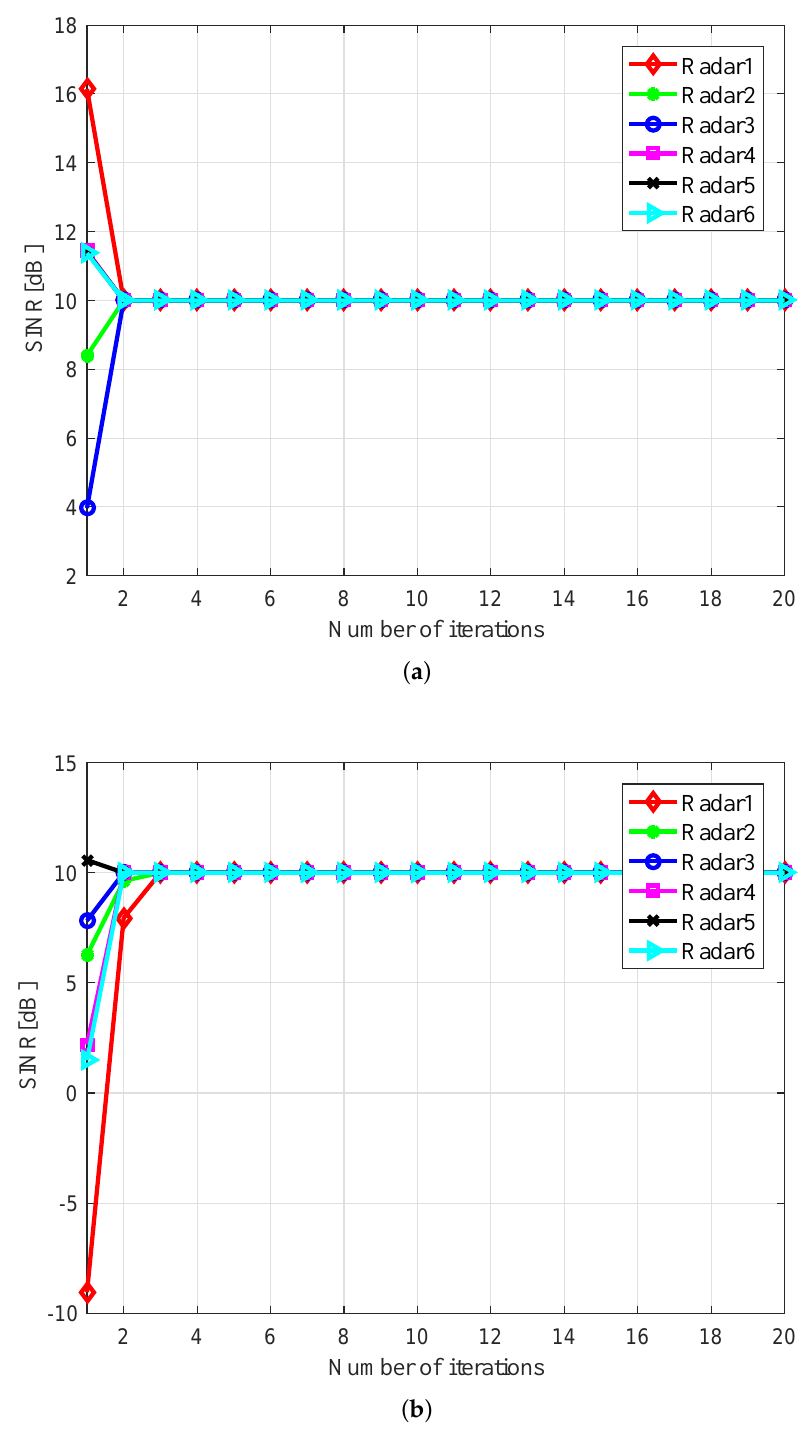
Figure 6. Convergence behavior for the achieved SINR of each radar in the first case: ( a ) Target position is [ 0,0 ] km; ( b ) Target position is [ − 30, − 40 ]